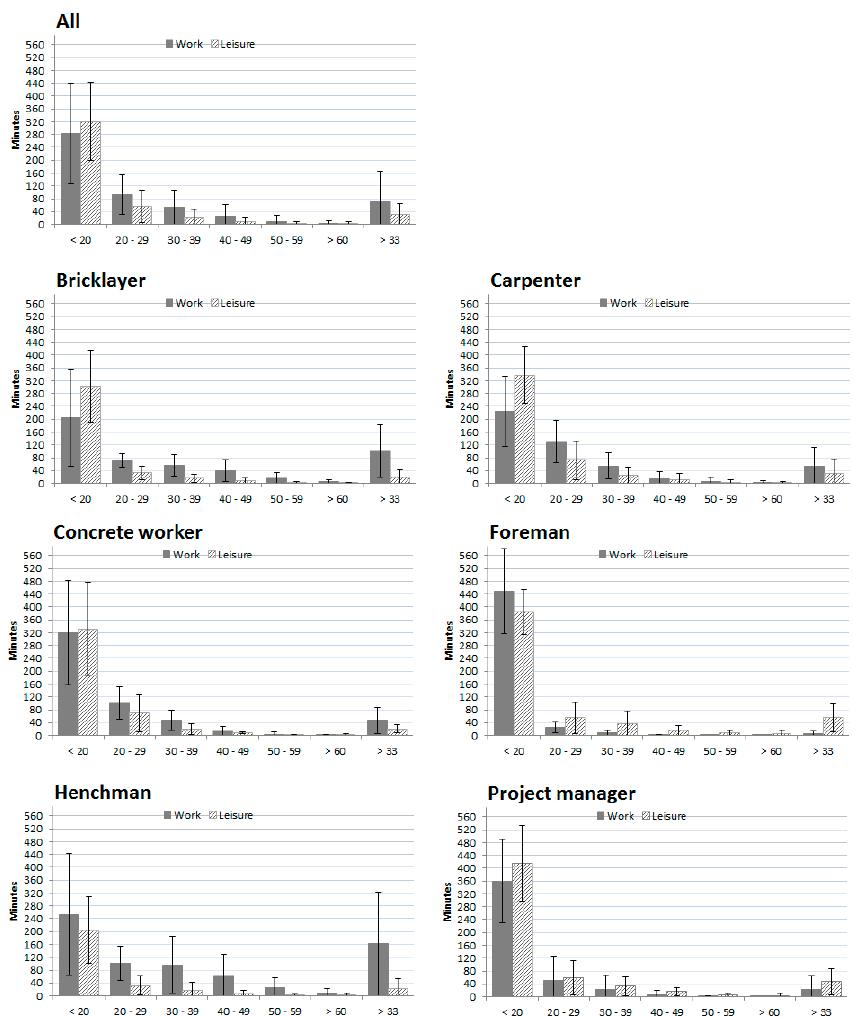
Figure 2. Relative heart rate distribution during work and leisure presented as minutes with standard deviation. During work : All; n = 42, Bricklayer; n = 5, Carpenter; n = 12, Concrete worker; n = 8, Foreman; n = 4, Henchman; n = 8, Project manager; n = 5. During leisure : All; n = 36, Bricklayer; n = 3, Carpenter; n = 11, Concrete worker; n = 7, Foreman; n = 4, Henchman; n = 6, Project manager; n = 5.